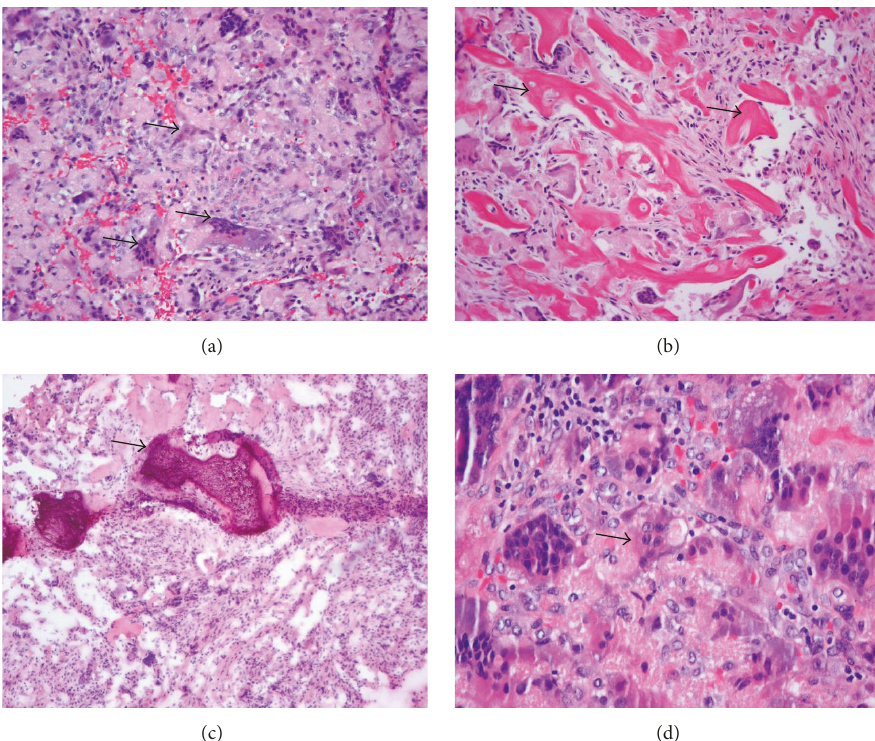
Figure 3: (a) Large numbers of giant cells present in a fibroblastic background (H&E stain-intermediate power; denoted by black arrows). (b) Osteoid-like material in a fibrous background (H&E stain-intermediate power; denoted by black arrows). (c) Dystrophic calcifications (H&E stain-intermediate power; denoted by a black arrow). (d) Ingestion of foreign material by a giant cell (H&E stain-high power; denoted by a black